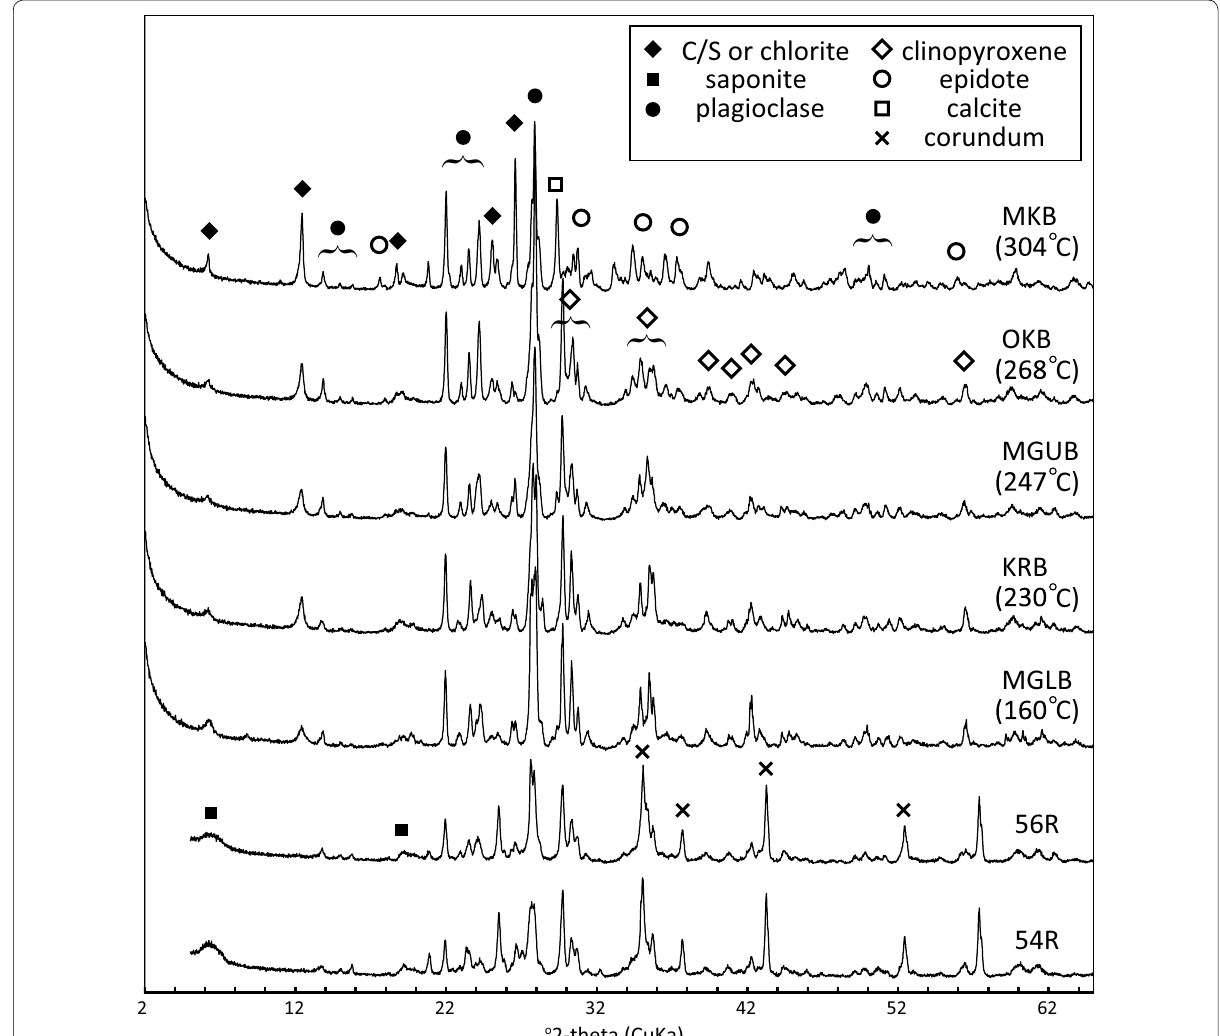
Fig. 3 Bulk XRD patterns for random powdered specimen mounts with sample abbreviations as per Fig. 1. The patterns of 54R-1w and 56R-1w are from ground powders mixed with